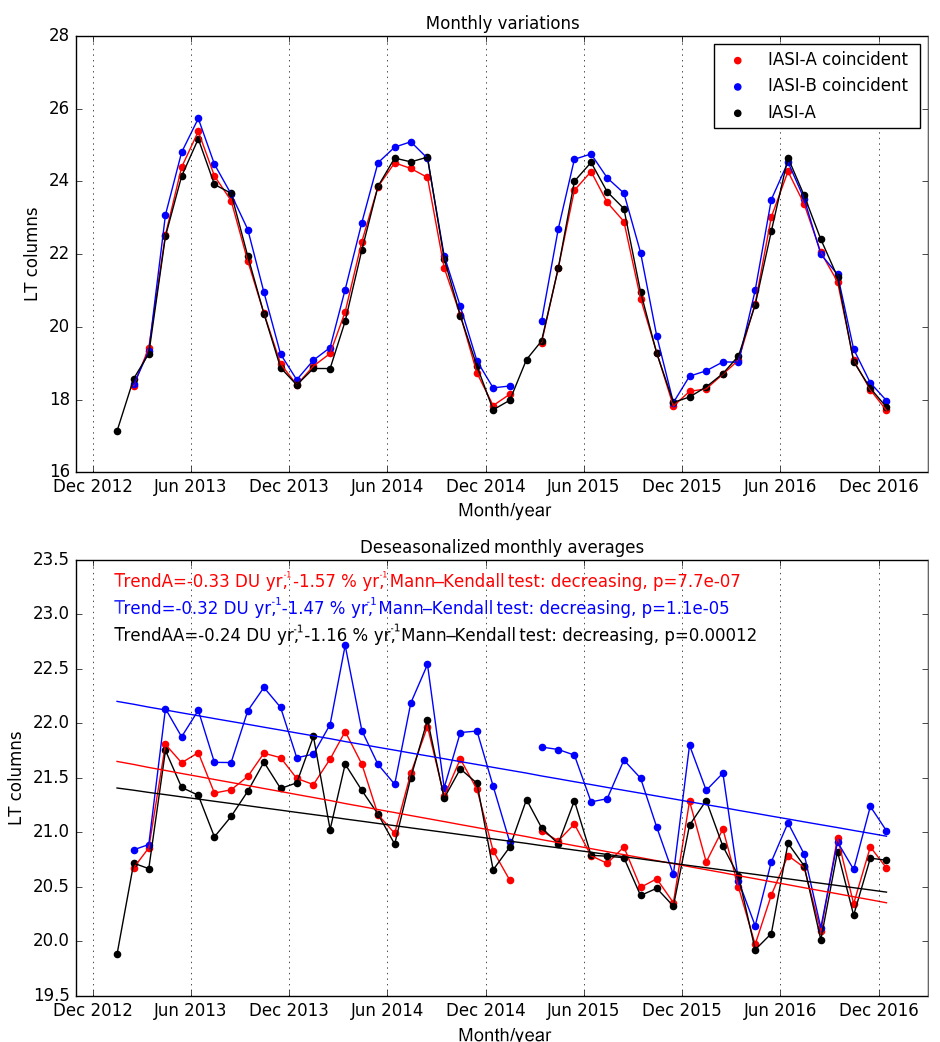
Figure 4. Monthly time series of IASI-A and IASI-B (blue). The IASI-A time series is plotted in red when in coincidence with IASI-B and in black when all IASI-A observations are considered. The deseasonalized time series and the corresponding linear trends are given in the bottom